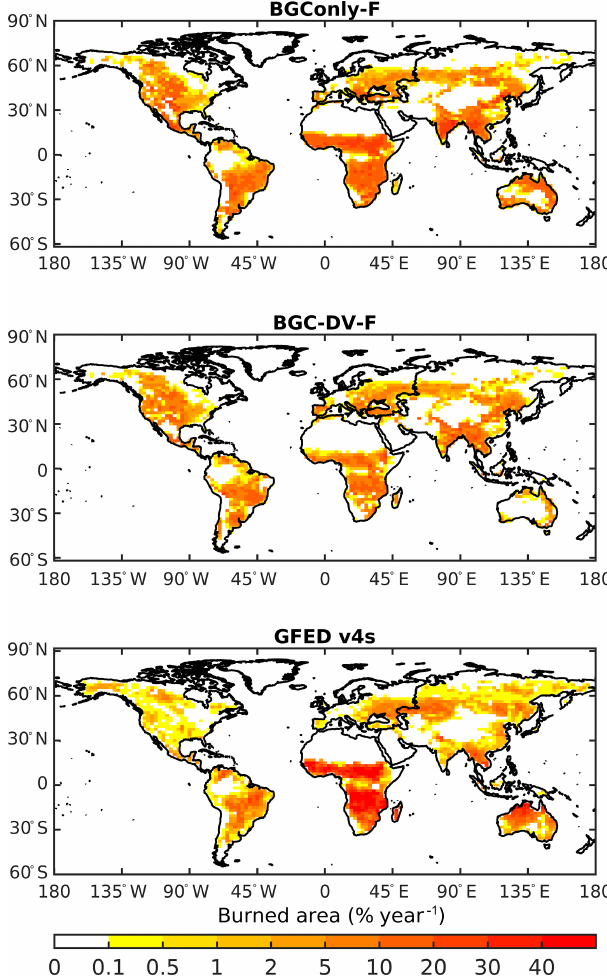
Figure 2. Annual burned area percentage by grid cell for CLM4.5BGC with fire (BGConly-F), CLM4.5BGCDV with fire (BGC-DV-F), and Global Fire Emission Database version 4 with small fires